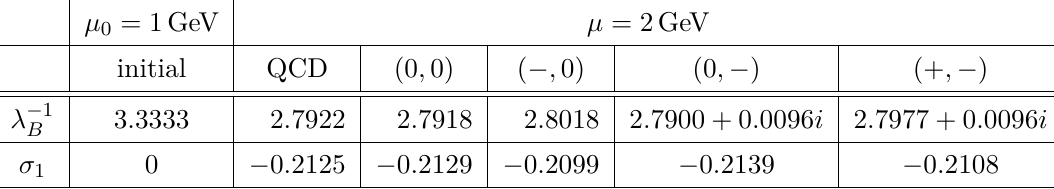
(in units of GeV − 1 ) and σ 1 with ˜ µ = ω 0 e − γ E and ω 0 = 0 . 3 GeV B